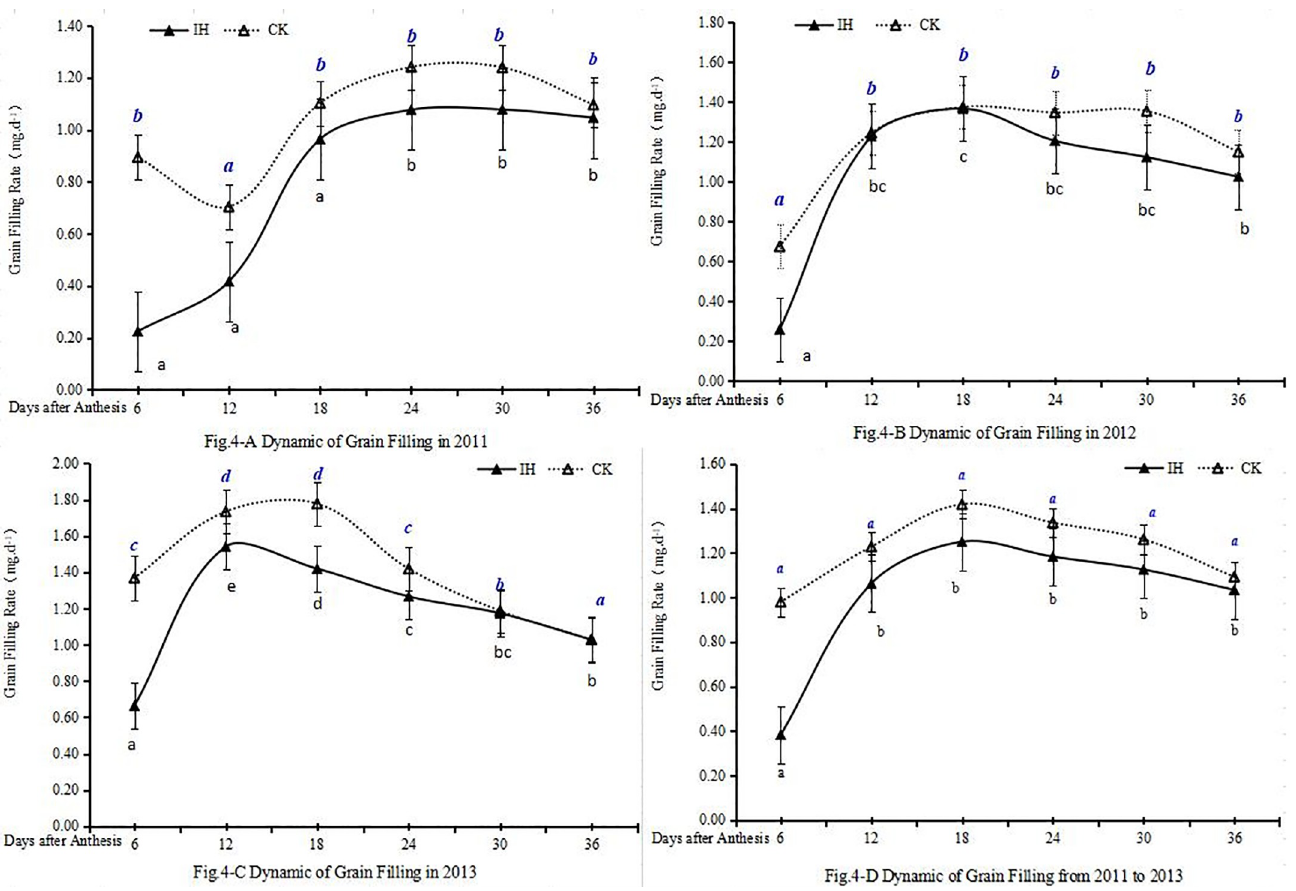
Fig 4. The grain filling rate dynamics of IH and CK in different season crops (4-A, 4-B, 4-C and 4-D mean in 2011, 2012, 2013 season crops and the average rate from 2011 to 2013 season crops). (Note: The letters of the dynamic line mean there were significant differences at the level of 0.05).